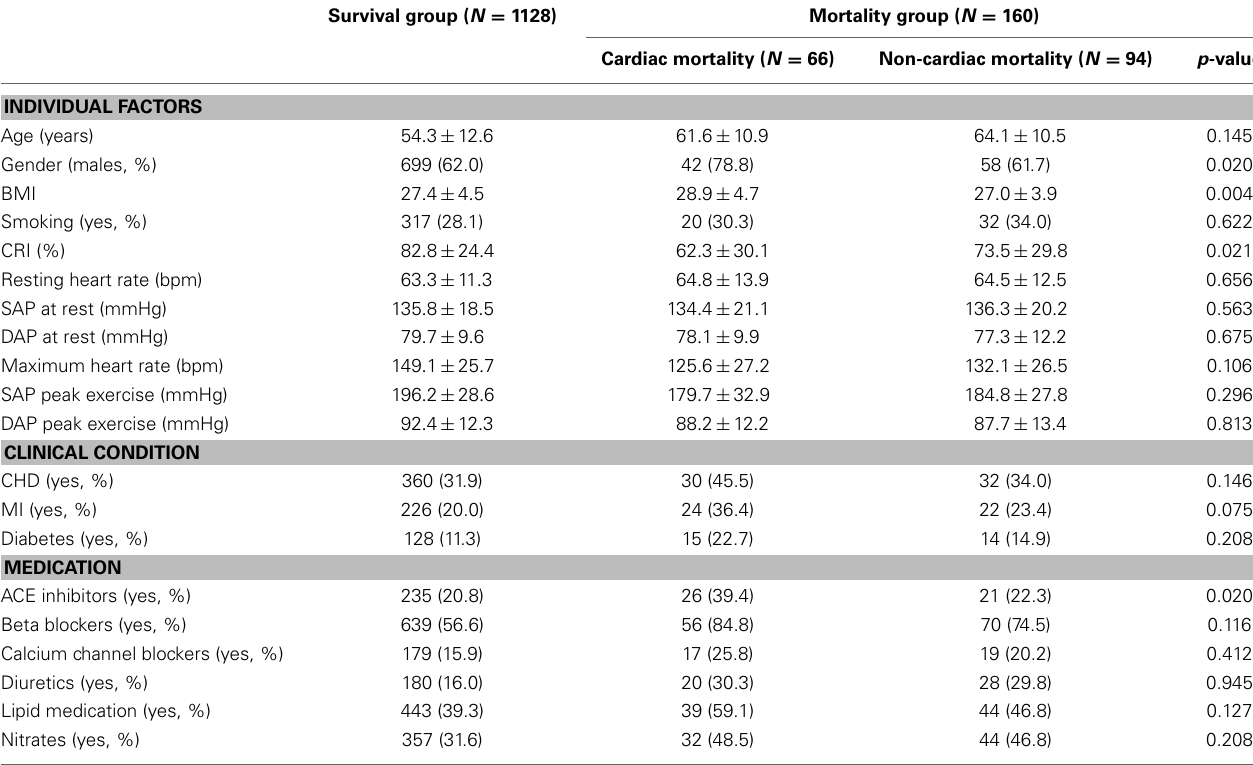
Table 1 | Baseline characteristics of the study population, classified into survival, cardiac, and non-cardiac mortality groups. Survival group ( N =